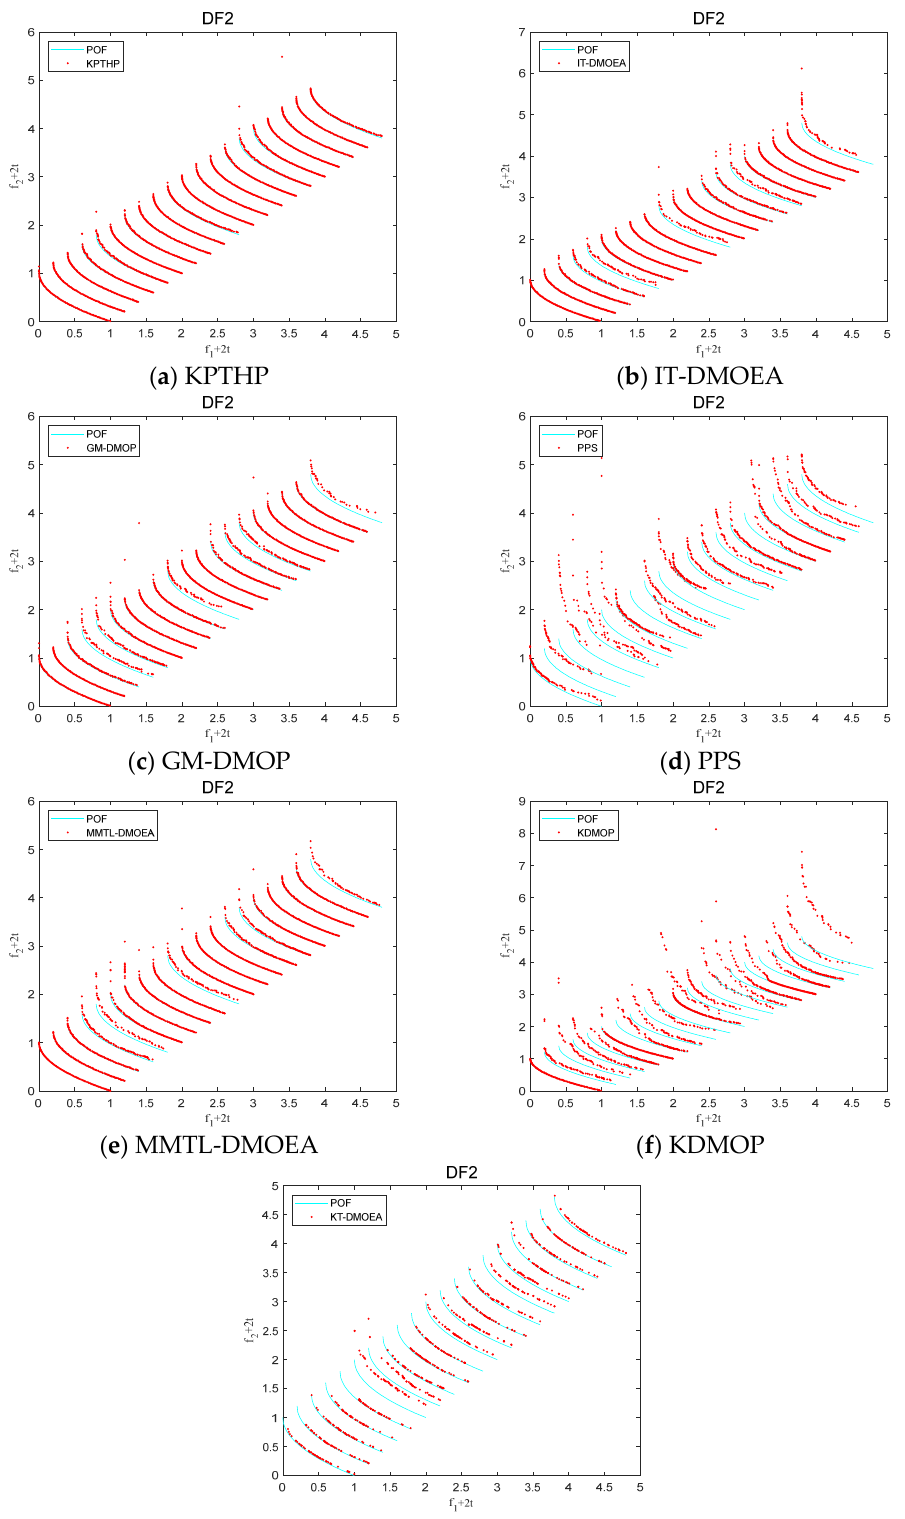
Figure 9. The POF of DF2 obtained by the seven algorithms. For IT-DMOEA, because the evolution of the population relies on the role of the ref- erence vector, the capability of generating the guided population decreases in the case of